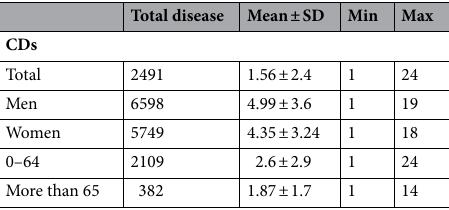
Table 2. The mean, minimum and maximum number of CD patients by sex and age group.